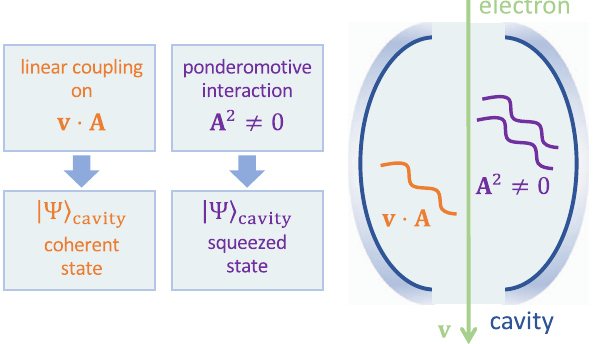
Figure 1: Free-electron interaction with an optical cavity. We present a sketch of the interaction for a single-mode cavity. Both linear ( ∝ v · A ) and quadratic (ponderomotive ∝ A 2 ) terms in the quantum vector potential operator A are present in the minimal-coupling light–matter interaction Hamiltonian. Switching on and off these two terms selects the creation of either coherent or squeezed cavity mode states,